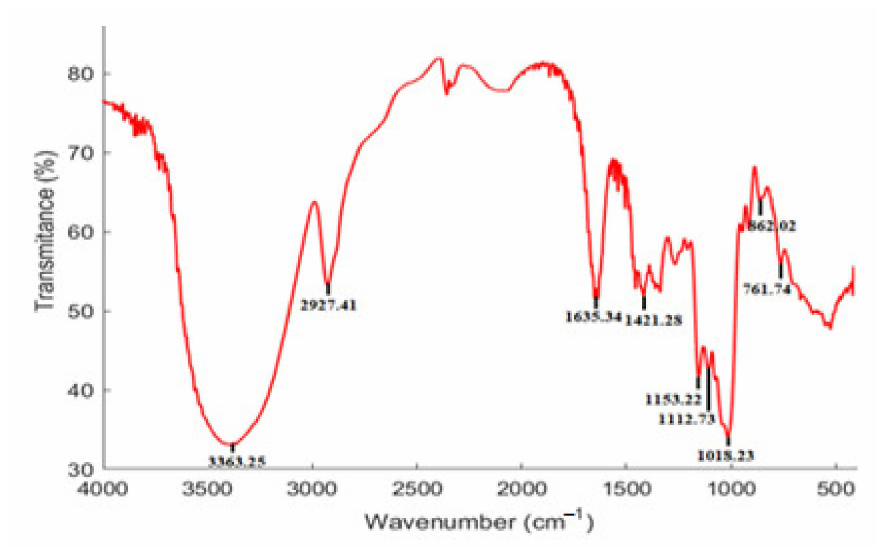
Figure 3. FT-IR spectrum of NPPc.